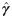
Scenario II. Coefficient of determination (R2) and root mean square error (RMSE) resulting from the solution of the linear regression problem with least-squares for the mortality rate (γ^).